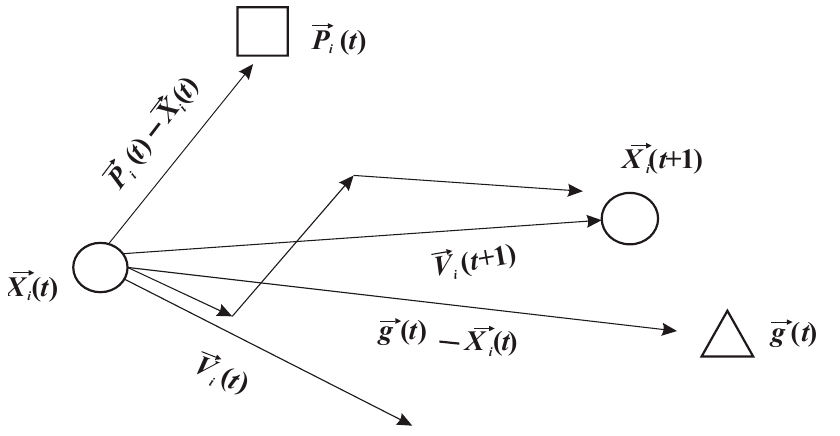
→ P i ( t ) is the personal best → X i ( t ) is the current best → ) is a point for a particular P i